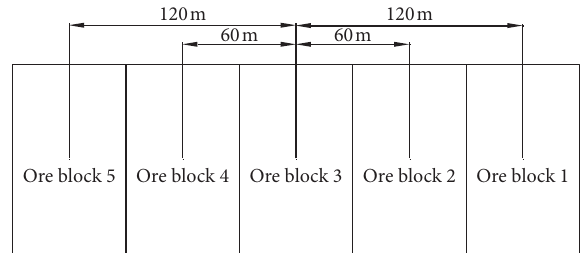
Figure 6: Calculating the center distance of the first step in scheme 1. Table 3: Sum of the center distances of the six schemes.